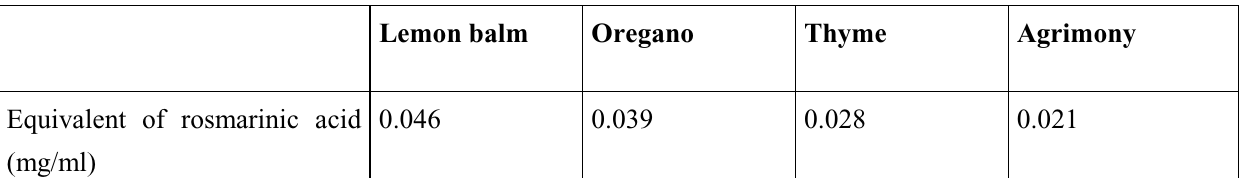
Table 2. Antioxidative activity of the plant extracts with the concentration of 1.0 mg dry plant / ml in the cleavage mixture expressed in the terms of the concentration of rosmarinic acid in the cleavage relative signal of the DNA marker (obtained using Figs. 3 mixture leading to the same value of the I/I 0 and 4).